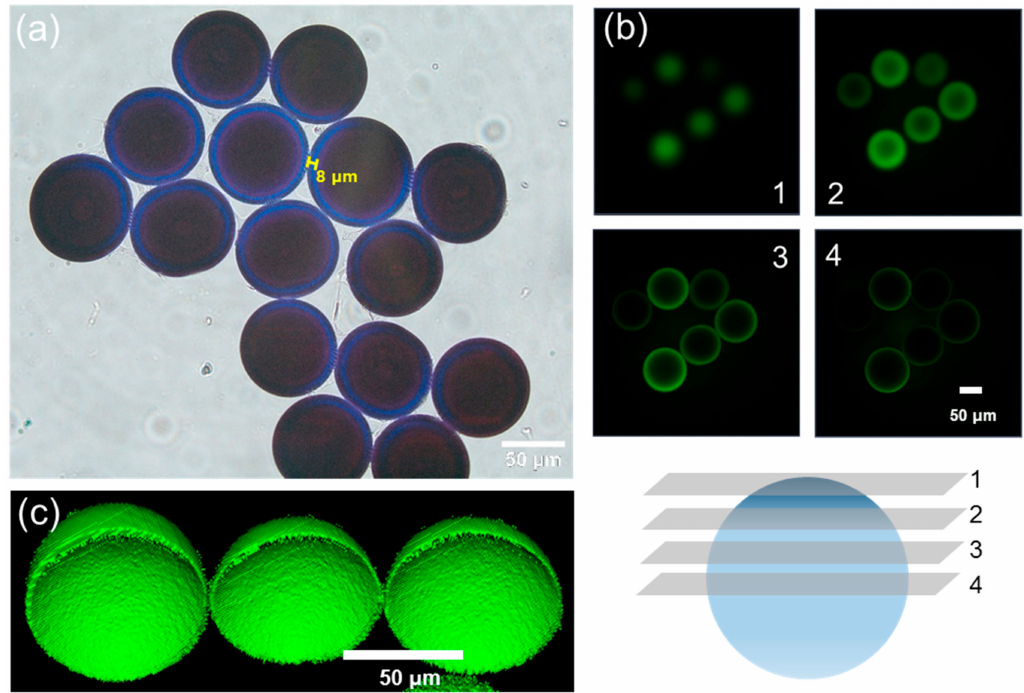
Figure 3. ( a ) Microscopic image of PEG-amine microbeads after bromophenol blue (BPB) staining. ( b ) Confocal laser scanning microscopic (CLSM) images of fluorescein isothiocyanate (FITC)-labeled PEG-amine microbeads at di ff erent z-levels and ( c ) three-dimensional reconstructed z-stack image.